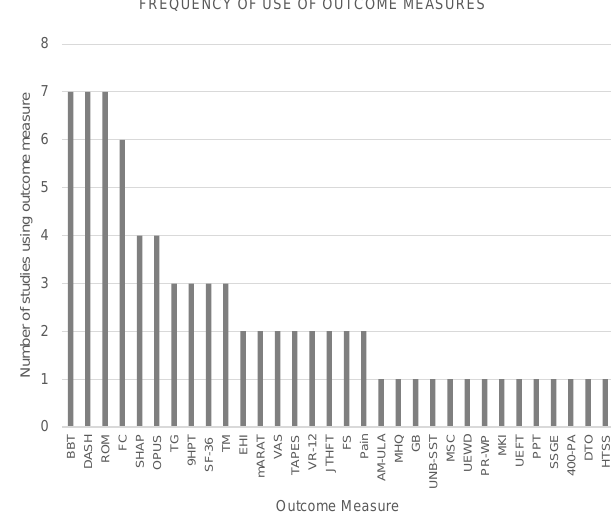
Figure 2 : Graph depicting number of times each outcome measure was used across the included studies.